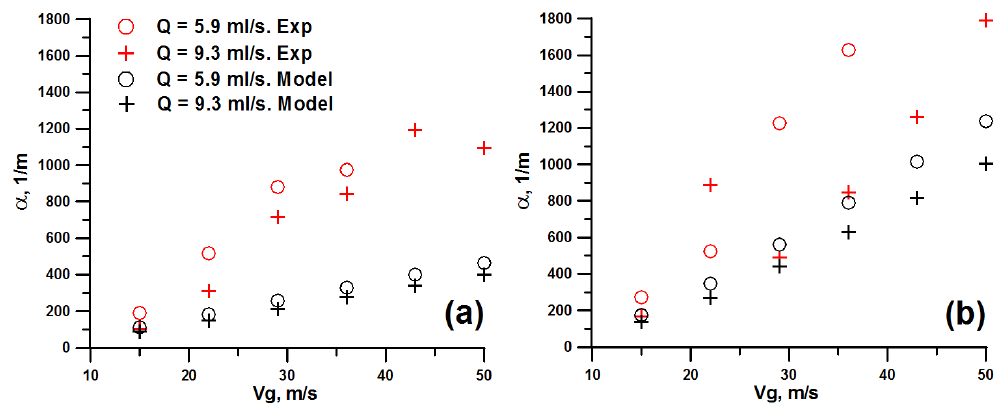
Figure 11. Comparison of the measured against the calculated increment of amplitude growth: ( a )